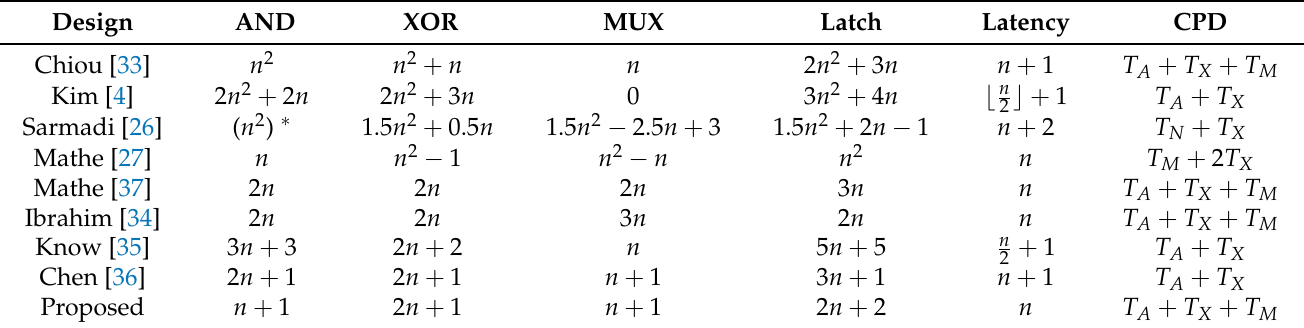
Table 1. Area and time-complexities of the proposed and the existing effective multipliers.